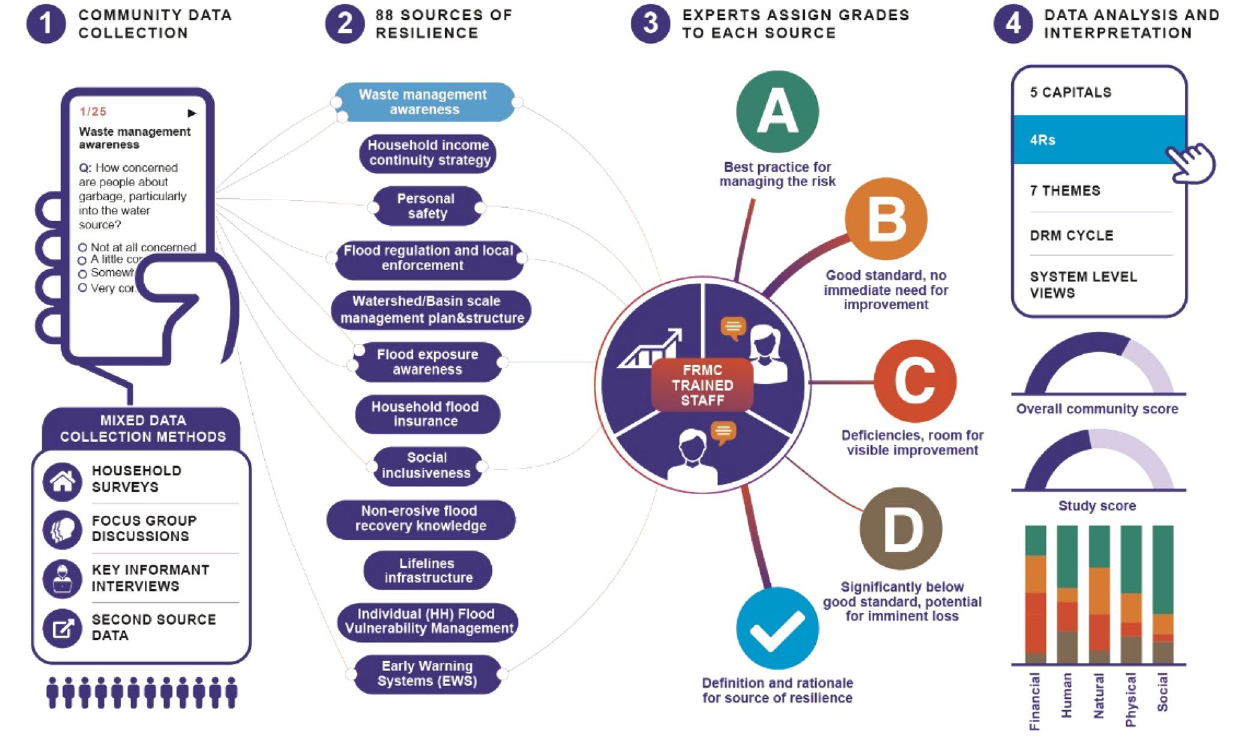
Figure 1. FRMT data implementation process. [Source: (Laurien et al. 14 )].